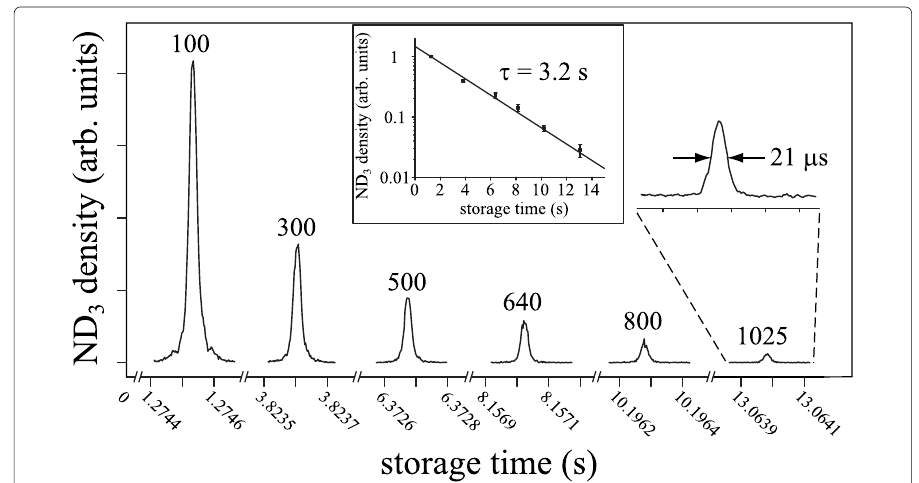
Fig. 4 Time-of-flight measurements of ammonia molecules traversing the synchrotron. The numbers above the peaks denote the number of round-trips the molecules have completed at the time of measurement. The inset shows that the 1 / e trapping time is 3.2 s. Reprinted with permission from Ref. [35] ©2010 APS